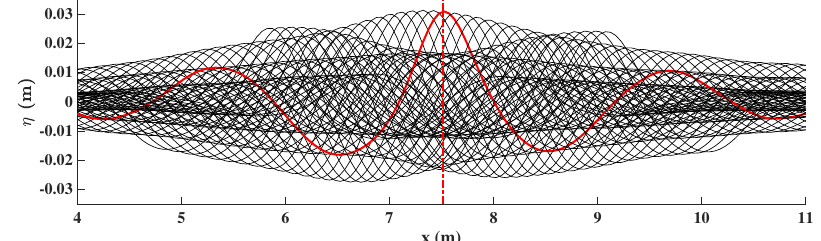
Figure 25. Wave profile envelop along the x-axis at y = 10 m, plotted with short time intervals around t F = 35 s.